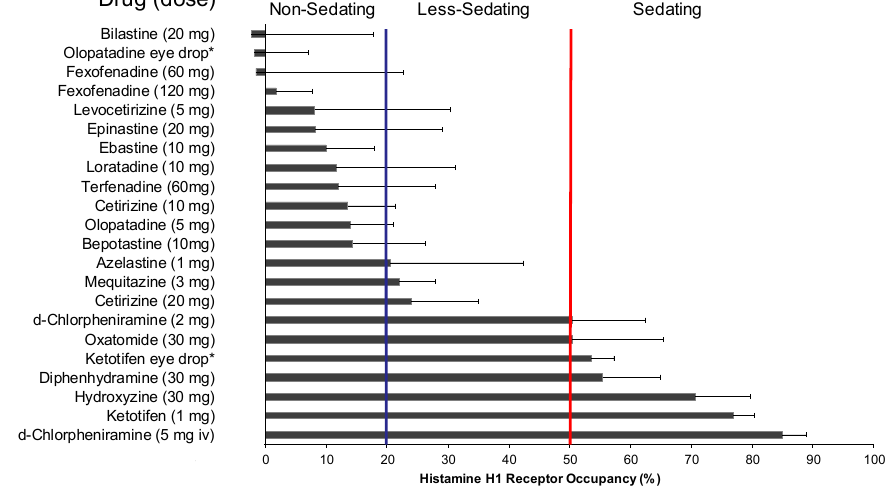
Figure 2. Brain histamine H 1 receptor occupancies of various antihistamines and classification for sedating actions. The occupancy data are represented as the mean ± SD of measurements in [ 11 C]doxepin-positron emission tomography after oral single-dose, eye drop (*), or intravenous (iv) administration of the drugs; the data were obtained by more than one research group. When H 1 receptor occupancy was 20% or lower, impaired performance was not observed in a simultaneously performed cognitive function test [19,21], and therefore, the drug could be classified as “non-sedating” (Modified based on